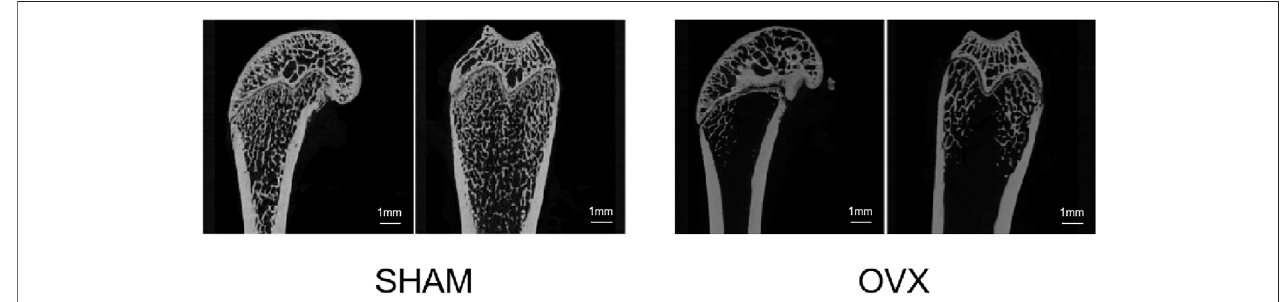
FIGURE 7 | Micro-CT scan section of rat femur. Compared to the sham operation (SHAM) group, the bilateral ovariectomized (OVX) group had reduced bone trabecular density and successful osteoporosis modeling.